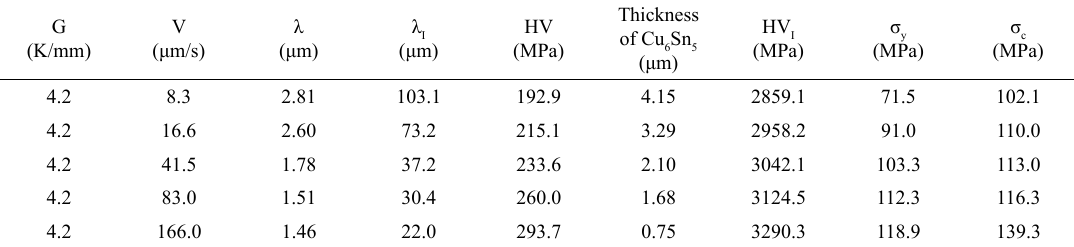
Table 1. Experimental data of the Sn-36Bi-22Cu alloy.